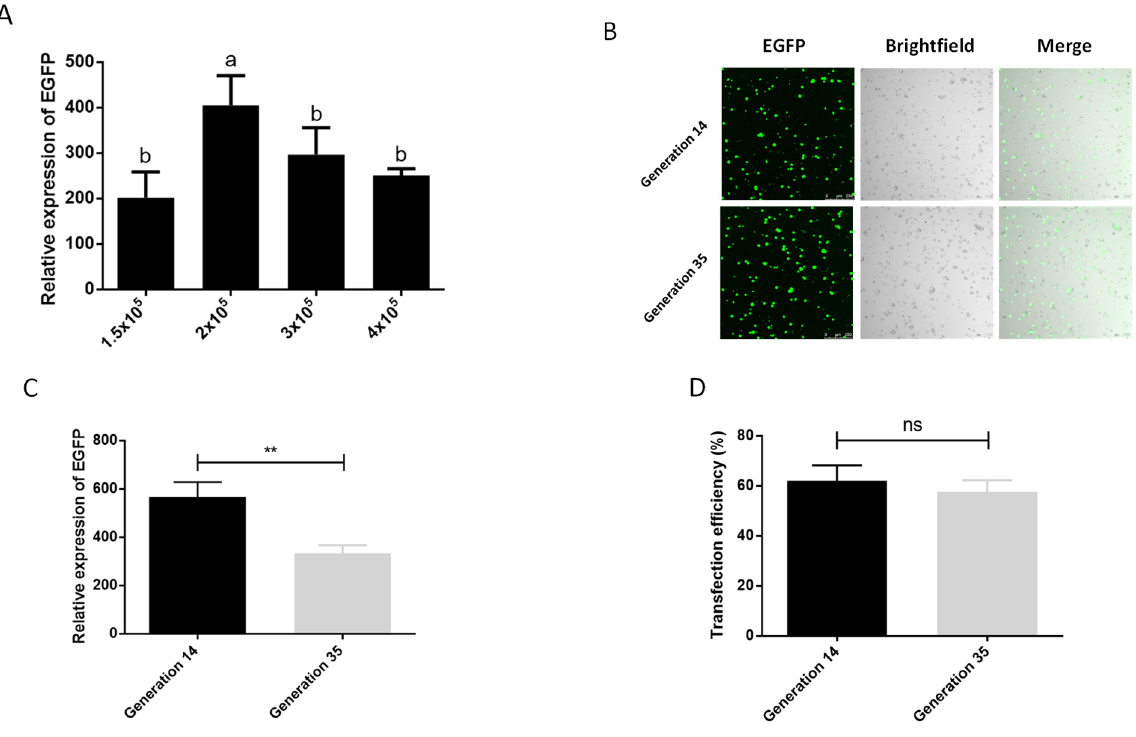
Figure 2. Effect of cell number and passage on transfection efficiency. ( A ) The effect of different cell numbers on the transfection. The significant differences between groups are indicated by lowercase letters (Duncan, p < 0.05). ( B ) Fluorescence image of cells after transfection. Photographed by laser confocal, exposure time and excitation light intensity are consistent during shooting. ( C ) The relative expression of EGFP after transfection of cells of different passages. ** indicates highly significant difference ( p < 0.01). ( D ) Transfection efficiency of cells of different passages. ns means no significant difference.